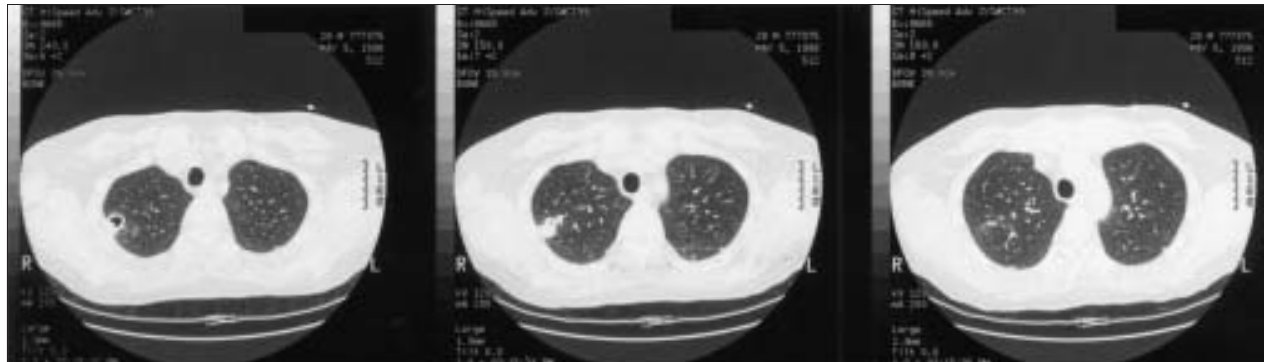
Figure 1) Computed tomography scan of the chest, showing a cavitary lesion in the lung on the right